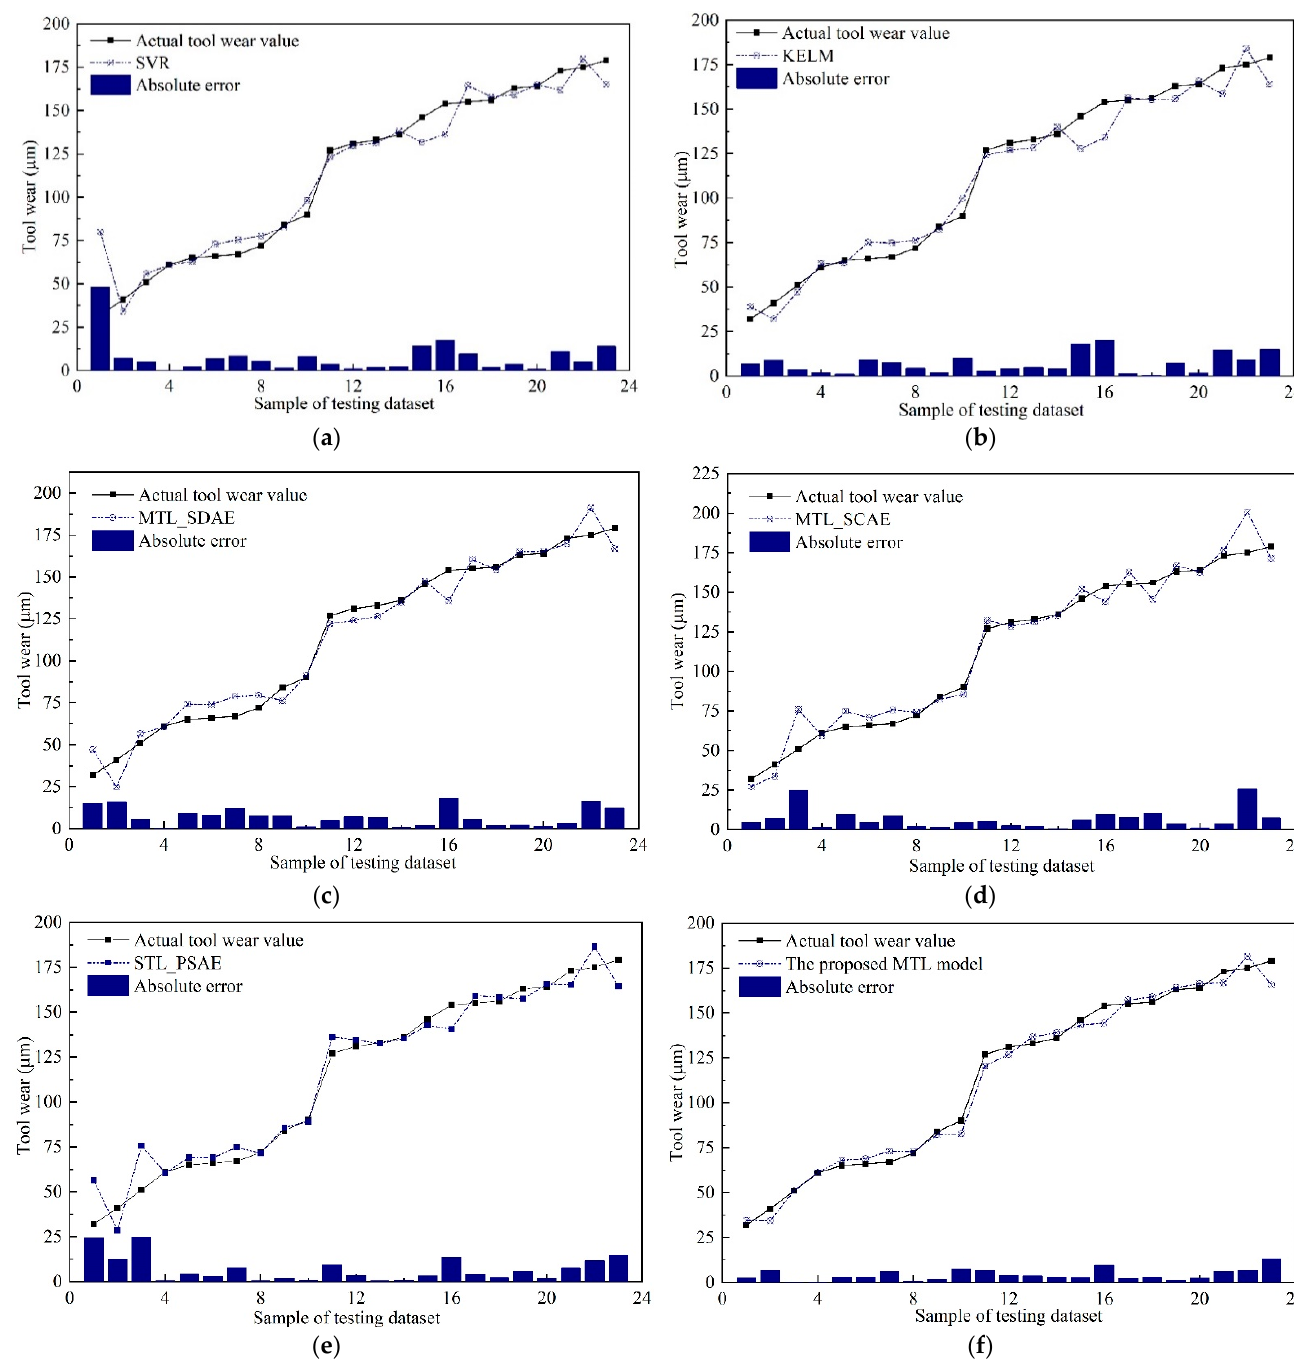
Figure 16. Tool wear prediction results of different models. ( a ) SVR; ( b ) KELM; ( c ) MTL_SDAE; ( d ) MTL_SCAE; ( e ) STL_PSAE; ( f ) The proposed MTL model.